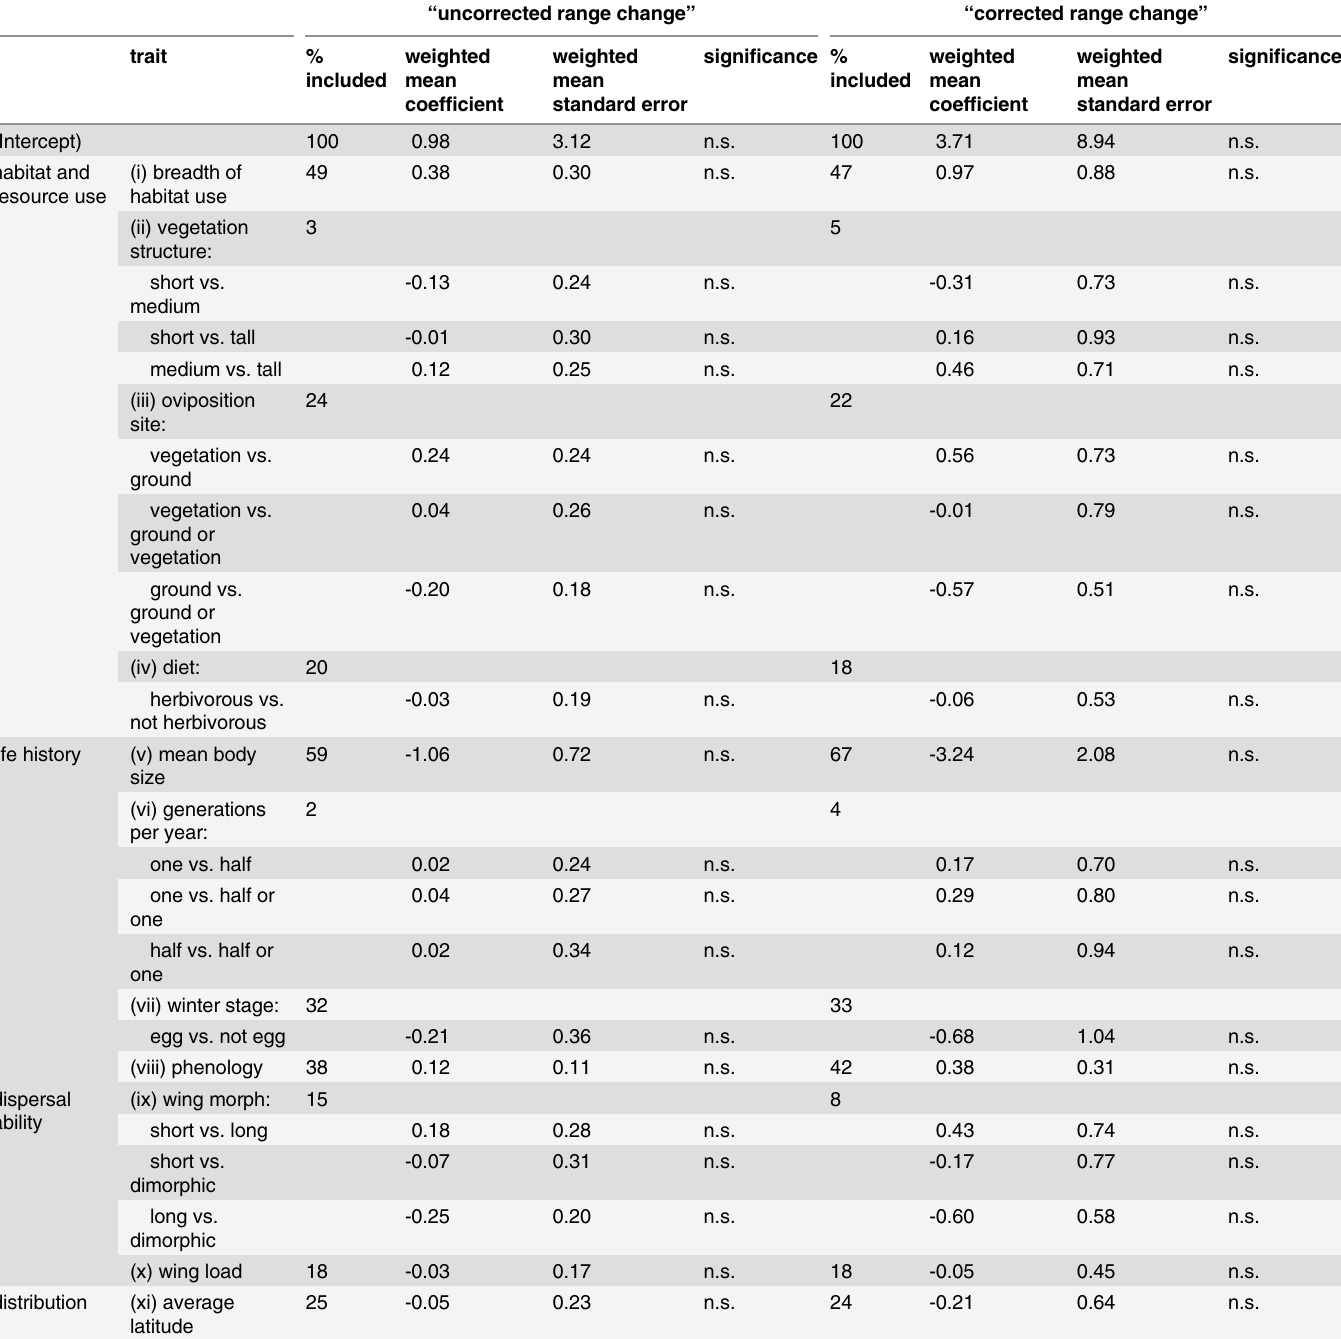
Summary of results for sets of top GLM models with Δ AIC < 4 (95 models for “ uncorrected range change ” , and 79 models for “ corrected range change ” ). The importance of traits is indicated by the frequency with which they are included in the top model set (% included), and by their weighted mean coef fi cients, standard errors and signi fi cance levels. Results given are for minimum adequate recording effort, i.e. for “ surveyed squares ” with a minimum of 1 species recorded in both 1980 – 9 and 2000 –